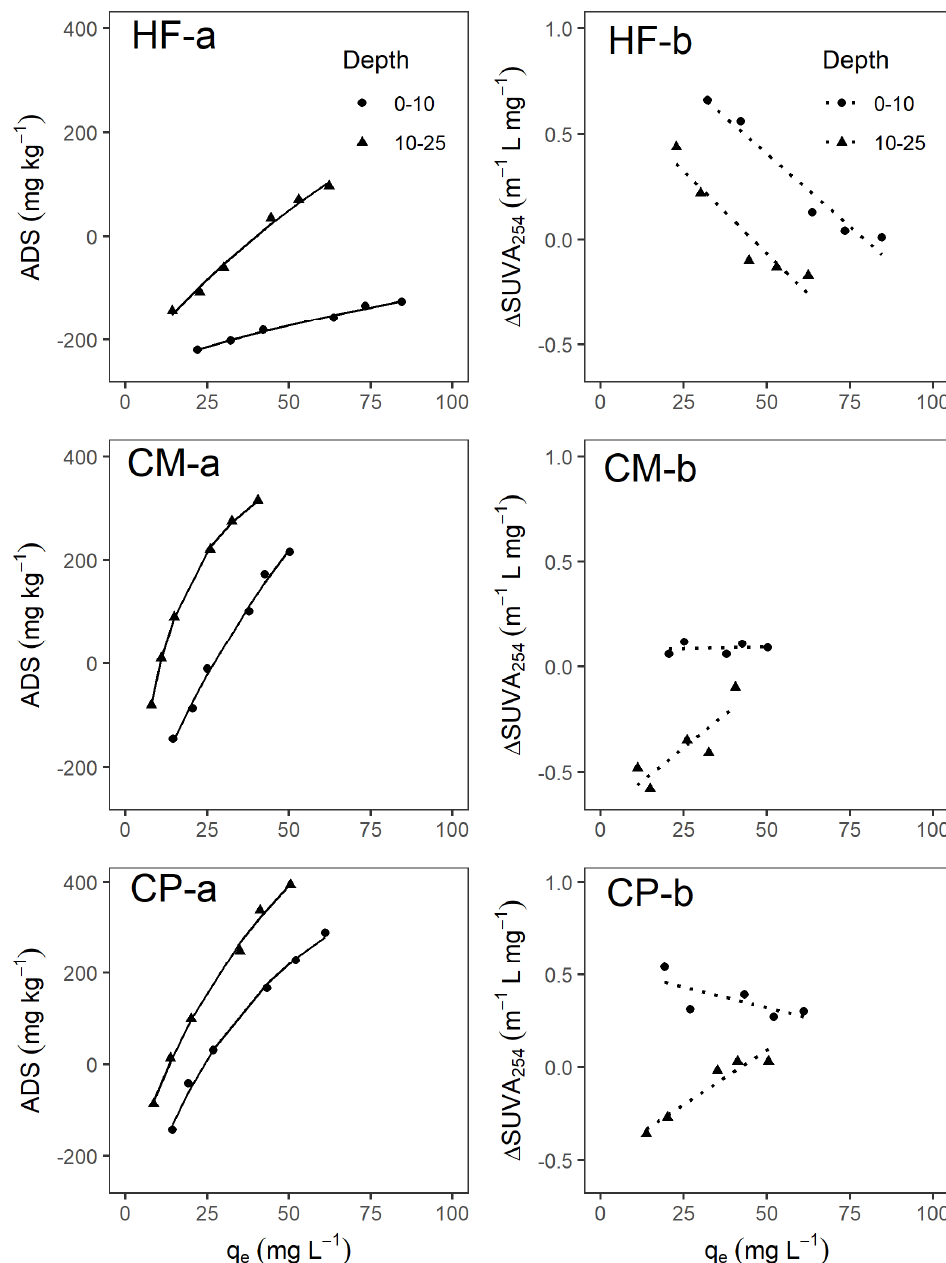
Figure 2. Dissolved organic carbon (DOC) sorption to the forest (HF-a), cropland (CM-a), and pasture (CP-a) soils and the change of SUVA 254 ( ∆ SUVA 254 ) of the DOC solution after sorption to the hardwood forest (HF-b), cropland with manure (CM-b), and continuous pasture (CP-b) soils at 0–10 cm and 10–25 cm depth. The solid lines were the fitted modified Langmuir isotherm. The dashed lines were the fitted linear regression. ADS: adsorbed DOC; ∆ SUVA 254 : The specific ultraviolet absorbance at 254 nm of filtered DOC in solution at equilibrium minus that of DOC at original